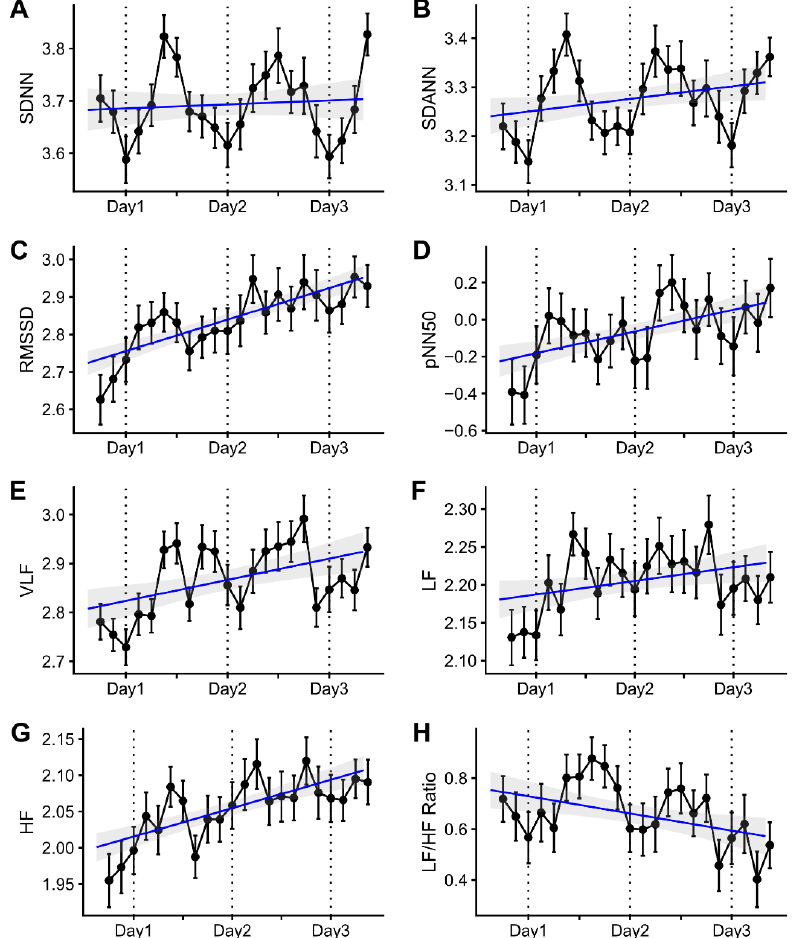
Figure 3. Changes in heart rate variability parameters during the long interdialytic period. The heart rate variability (HRV) parameters included time-domain parameters such as SDNN ( A ), SDANN ( B ), RMSSD ( C ), and pNN50 ( D ), and frequency-domain parameters such as VLF ( E ), LF ( F ), HF ( G ), and the LF/HF ratio ( H ). SDNN, SDANN, RMSSD, pNN50, and the LF/HF ratio values were natural log-transformed, and the VLF, LF, and HF values were square root-transformed. The HRV parameter values are presented as means and standard errors at three-hour intervals. The blue lines and gray areas represent linear regression lines and 95% confidence intervals. SDNN, standard deviation (SD) of normal-to-normal intervals during an hour; SDANN, SD of the averages of NN intervals in all five-minute segments during an hour; RMSSD, square root of the mean square of the differences between adjacent NN intervals; pNN50, percentage of the number of pairs of adjacent NN R-R intervals differing by >50 ms in the total NN intervals; VLF, very-low-frequency (0.003–0.04 Hz) power; LF, low-frequency (0.04–0.15 Hz) power; HF, high-frequency (0.15–0.40 Hz)